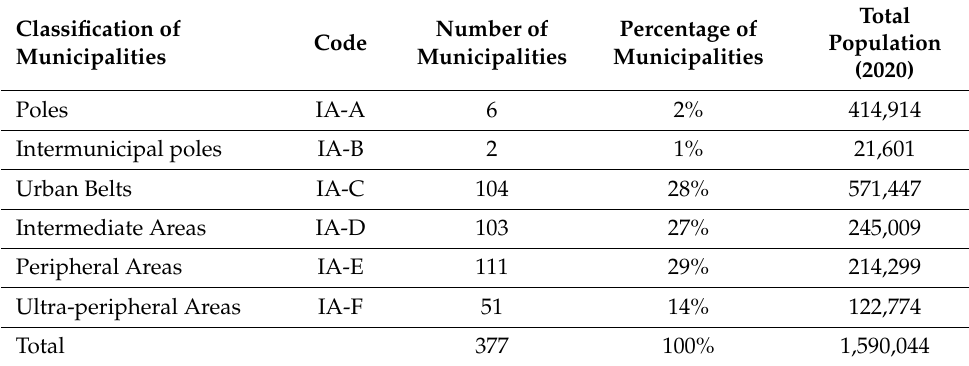
Figure 2. Comparison between the 2020 Strategy for Inner Areas ( left ) and the Territorial Capital ( right ) classifications. Table 2. Classification of Sardinian municipalities based on the SNAI classification: categories IA-E and IA-F are associated to a peripheral condition (Source: SNAI 2020).